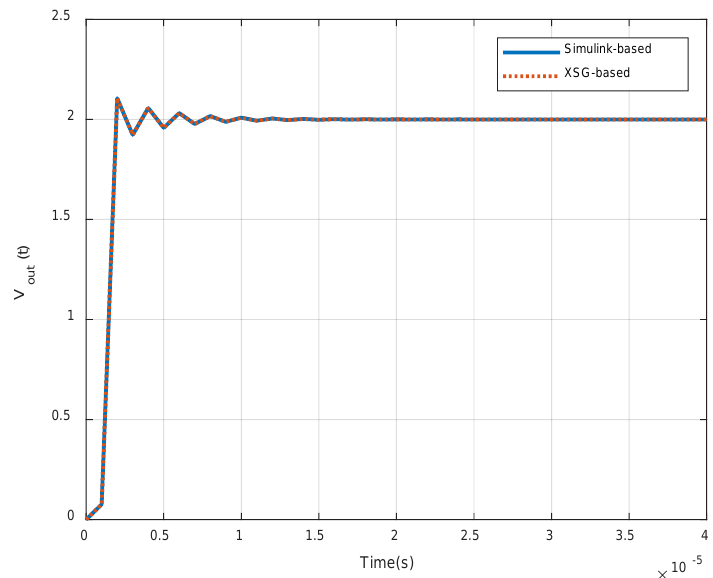
Figure 17. Output voltage response obtained through the Simulink and Xilinx System Generator (XSG)-based compensated system.